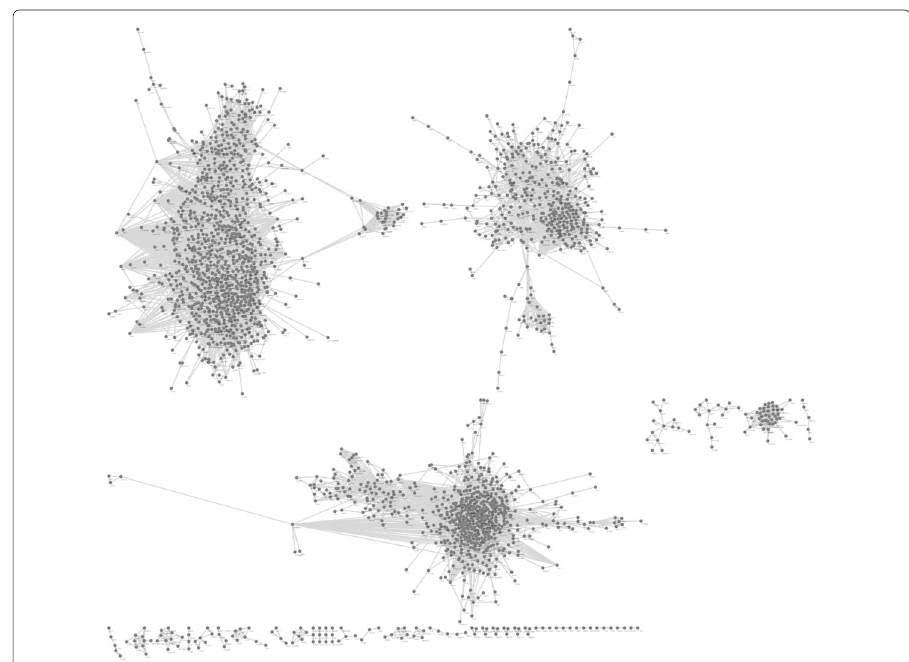
Fig. 3 Gene co-expression network generated with lung cancer dataset